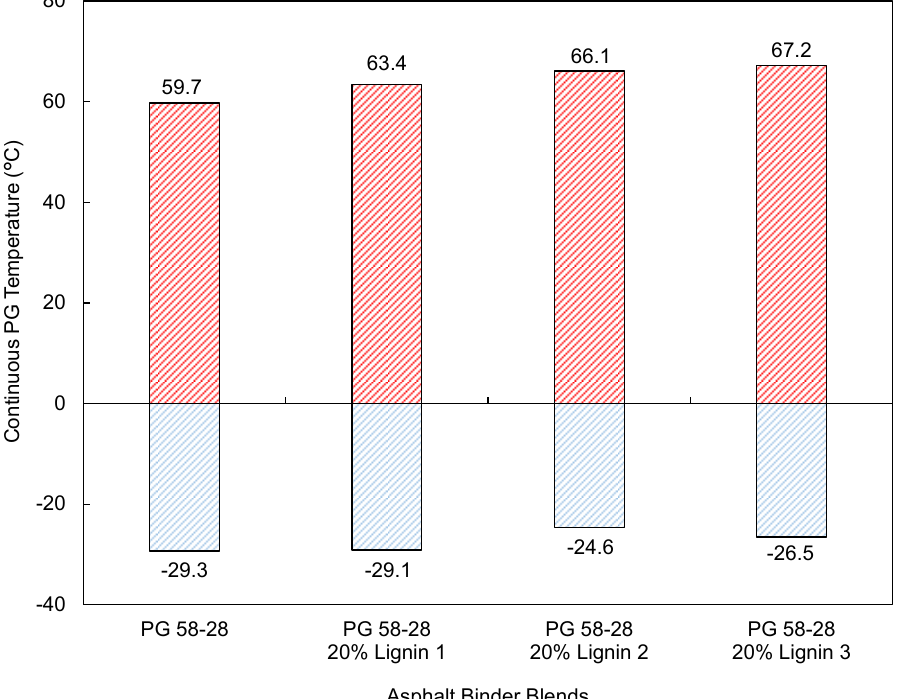
Figure 9. Continuous Performance Grades of Binder Blends.